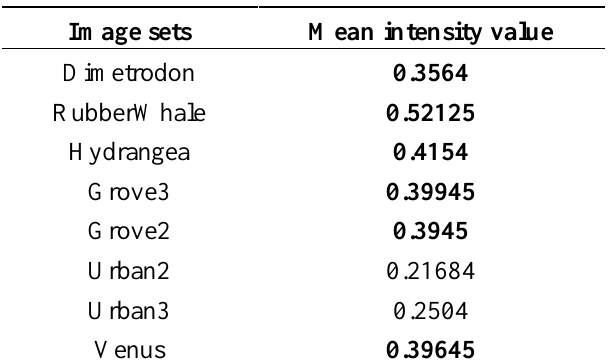
Table 6. Results of first